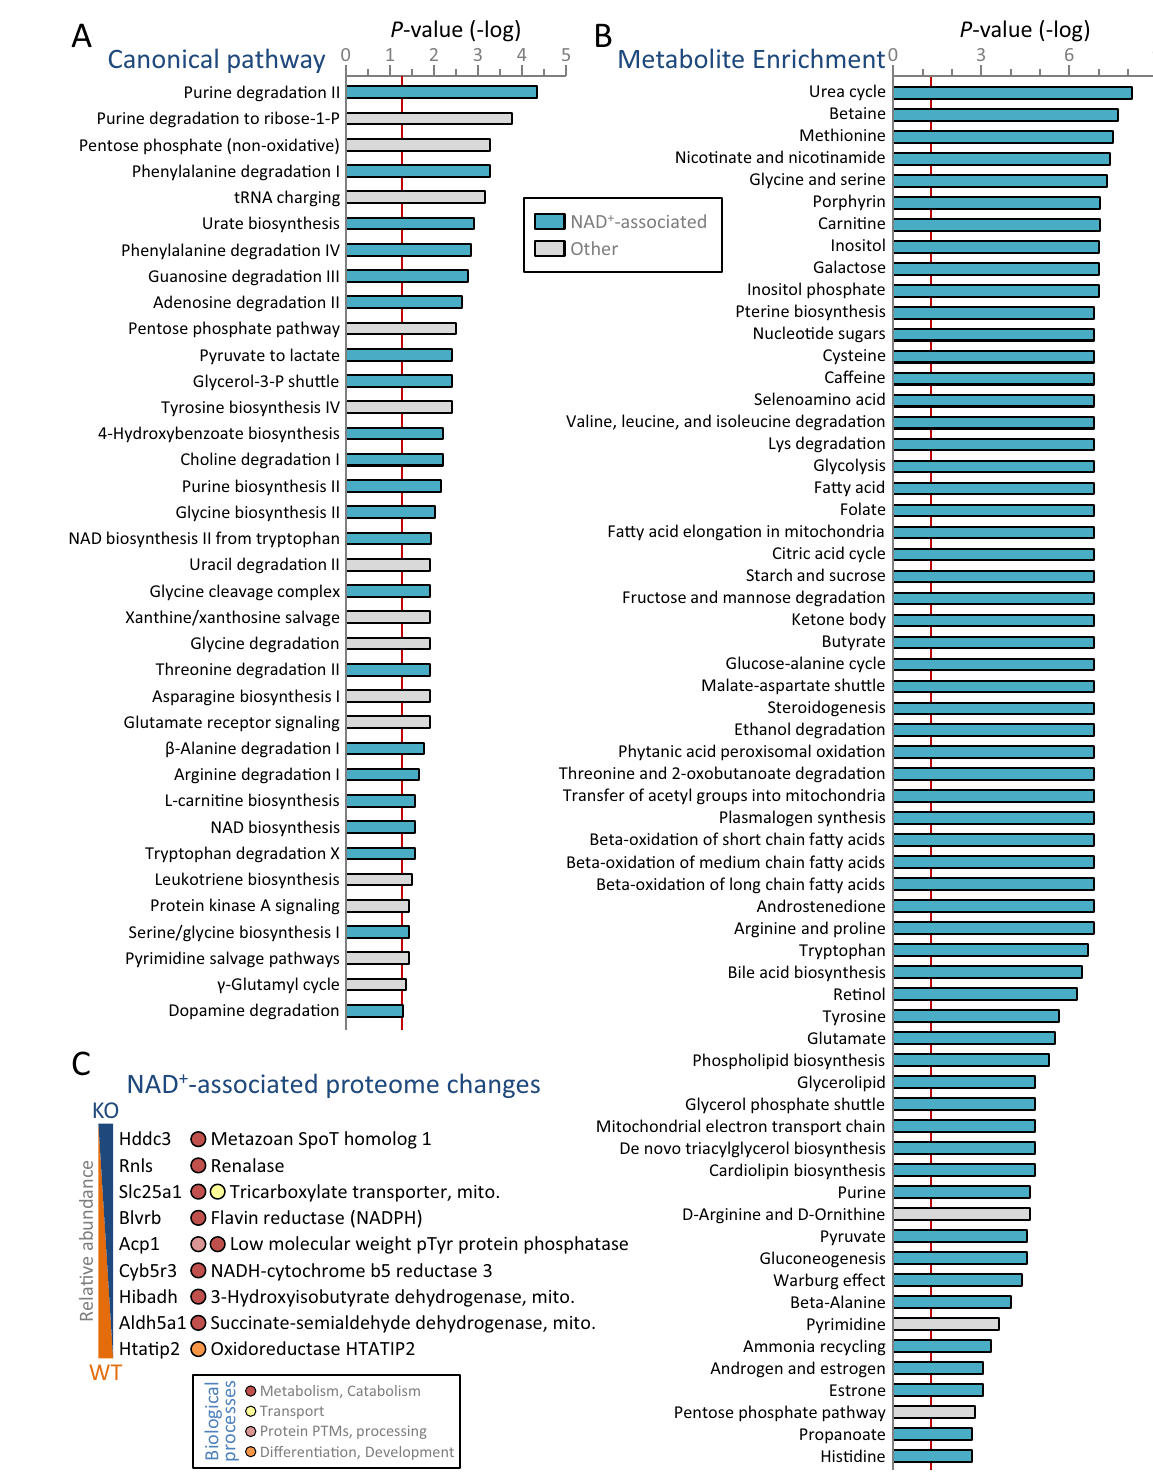
Figure 6. Cross platform validation of NAD + -dependent K ATP channel deficiency. ( A ) Enriched pathways arising from the Kir6.2 knockout (KO) versus wildtype (WT) differential metabolome (n = 10 per cohort) were identified in Ingenuity Pathway Analysis canonical pathways ( P < 0.05) documenting a predominant link to NAD + amongst all 27 differential metabolites associated with overrepresented pathways, with NAD + linking to 22 of 36 pathways and other differentially expressed metabolites linking to 12 or fewer. ( B ) Validating cross-algorithm evidence of NAD + dependence, Metabolite Set Enrichment Analysis specified NAD + linkage to 60 of 63 enriched metabolic pathways ( P < 0.05), whereas 26 other differential metabolites linked to 9 or fewer pathways each. ( C ) Within the corresponding proteome (n = 10 per cohort), 9 differentially expressed proteins were NAD + associated. Listed by gene symbol, biological processes, and protein name (mito. = mitochondrial), NAD + associated proteins were rank ordered by relative abundance in KO versus WT, with 8 linked to ‘Metabolism, Catabolism’